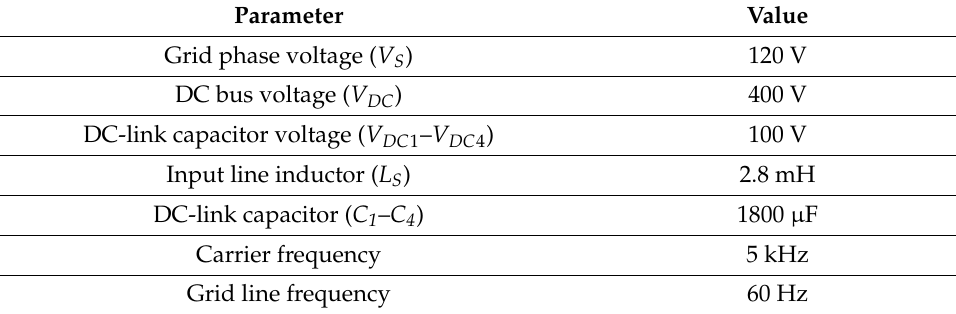
Table 4. Parameters of the experimental system.